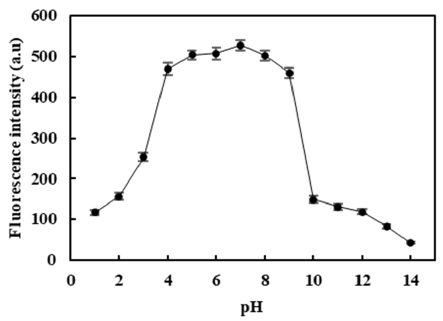
Figure 6. Effect of different pH values on the fluorescence intensity of CDs (excitation wavelength at 360 nm). 360 nm).